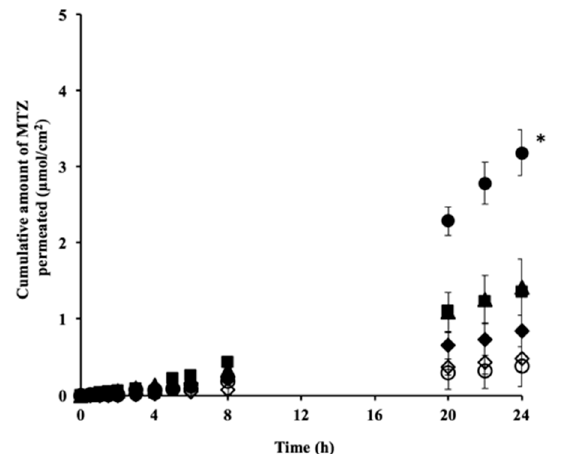
Figure 2. Permeation profiles of metronidazole (MTZ) through the excised hairless rat skin from its aqueous solution with or without a chemical enhancer. MTZ permeation was significantly (* p < 0.05) improved by isopropyl myristate (IPM) when compared with the aqueous solution without an enhancer (control) and other chemical penetration enhancers (CPEs). Symbols: : aqueous solution, : IPM MTZ , : propylene glycol (PG MTZ ), : dimethyl sulfoxide (DMSO MTZ ), : ethanol (EtOH MTZ ), :